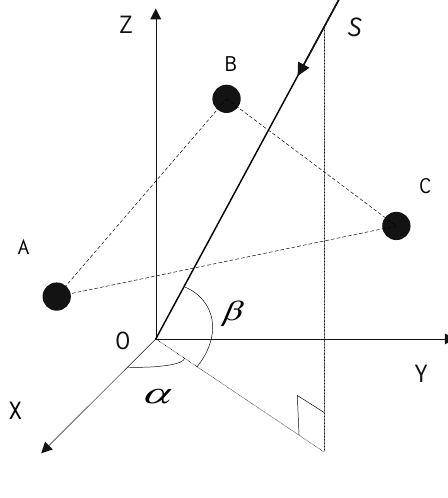
Figure 4. Model of arbitrary baseline algorithm.